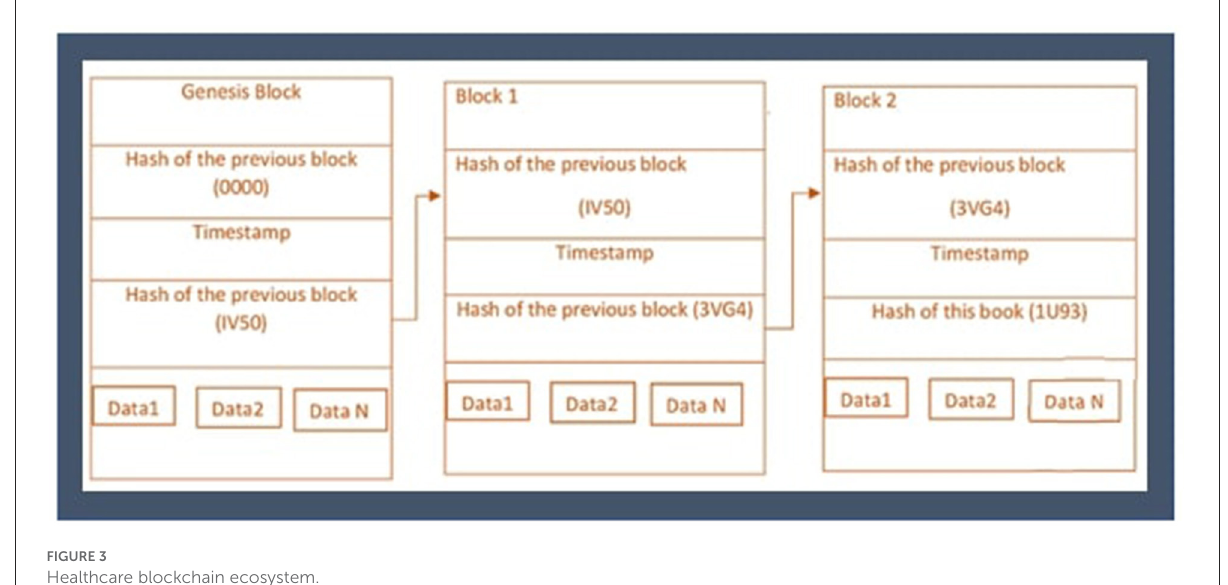
FIGURE3 Healthcare blockchain